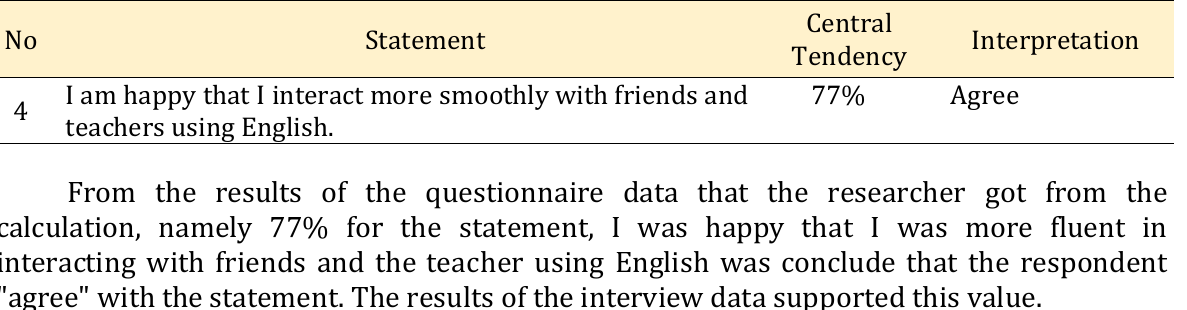
Table 4. Statement 4 questionnaire and interview